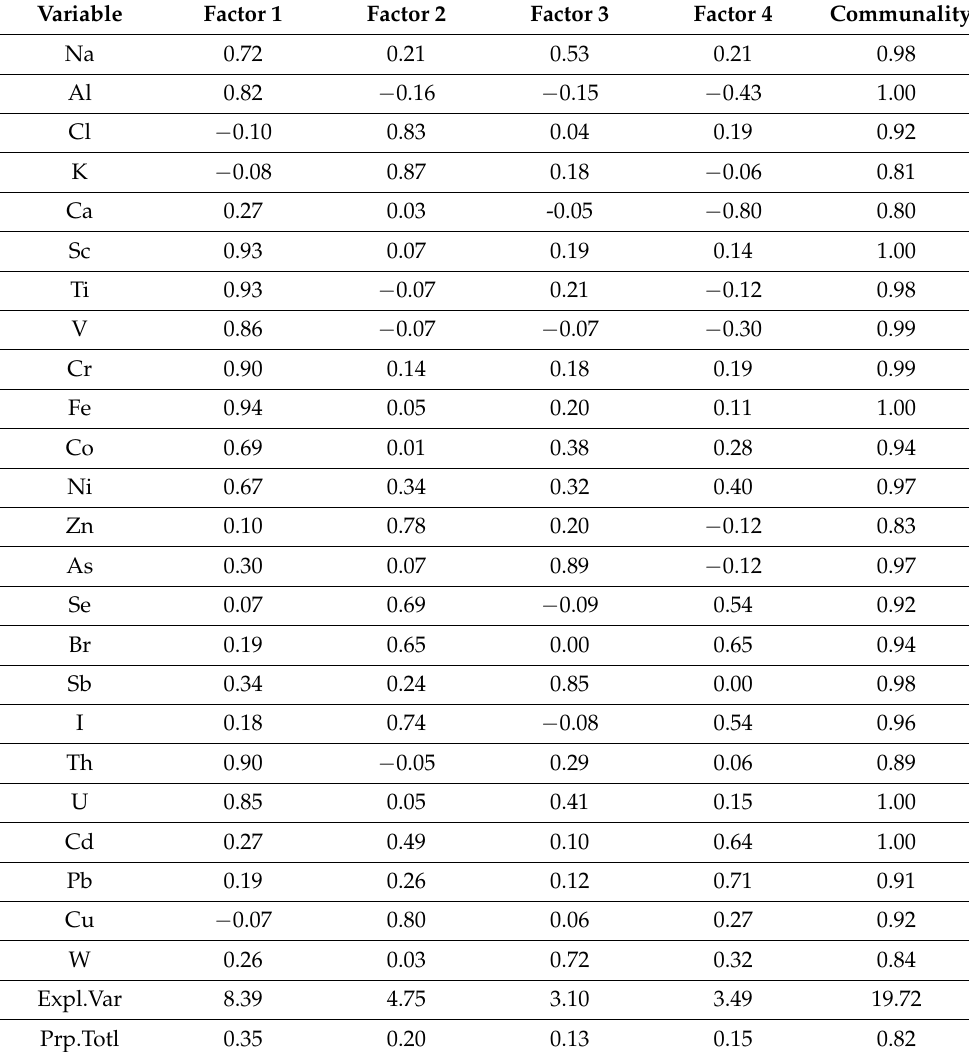
Table 4. Rotated factor loadings for the Central Georgia data set (36 samples). Varimax normalized. Extraction: Principal components (Marked loadings are >